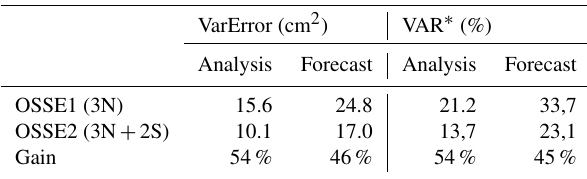
Table 2. SSH ocean analysis and forecast error statistics during the year 2015. Columns 1 and 2 represent the analysis and forecast vari- ance of error computed from the difference between the OSSE and the NR (VarError, cm 2 ). Columns 3 and 4 show the OSSEs error variance relative the FR error variance (Var*, %).